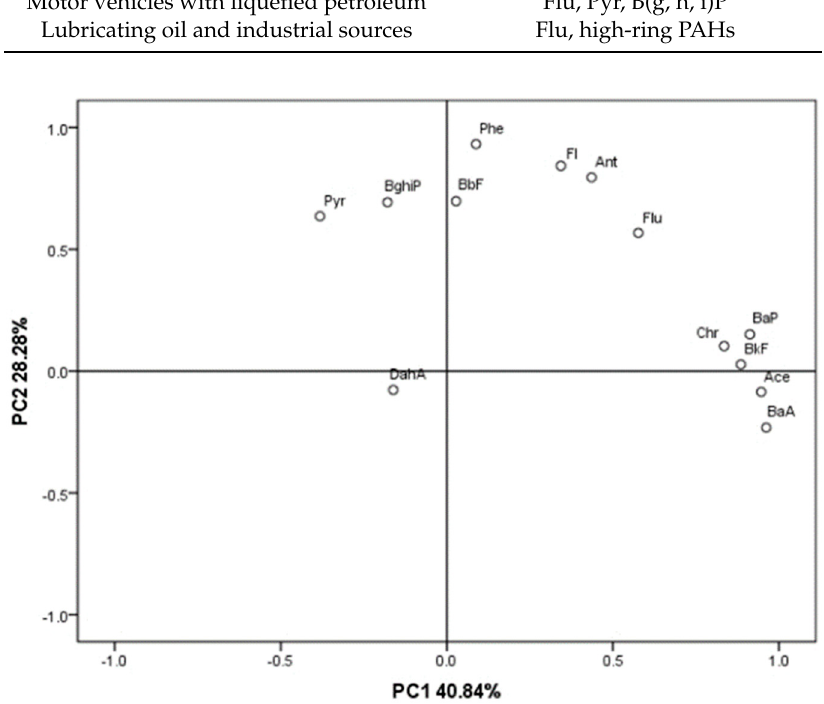
Figure 5. PAHs principal component analysis load. Table 3. Characteristic compounds emitted from various sources [23–28].